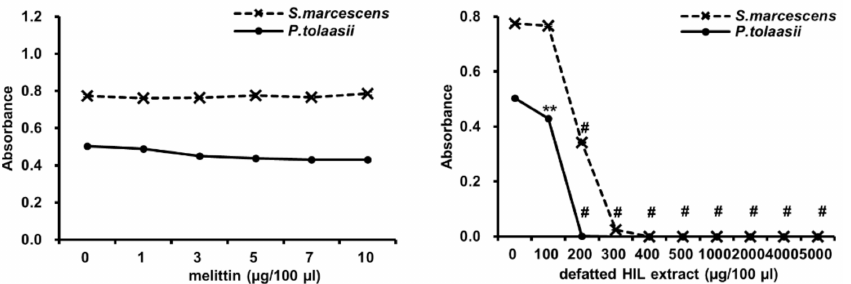
Figure 5. Antimicrobial activity of melittin and defatted HIL extracts against AMP-resistant S. marcescens and P. tolaasii . Briefly, 1 × 10 6 cfu/mL of 90- µ L S. marcescens or P. tolaasii suspensions were treated with various concentrations of 10- µ L melittin or defatted HIL extract dissolved in 0.05% acetic acid solution. Then, bacteria were grown for 24 h at 37 ◦ C. The experiments were independently performed in triplicate. A concentration of 0 µ g/100 µ L of melittin and defatted HIL extract indicates 0.05% acetic acid alone. The statistical analysis was performed by Student t -test. The significant differences were determined by comparing the absorbance of each experimental group with the control (0 µ g/100 µ L). Each value represents the means ± standard deviations of absorbance. ** and # indicate p < 0.05 and p < 0.0001,